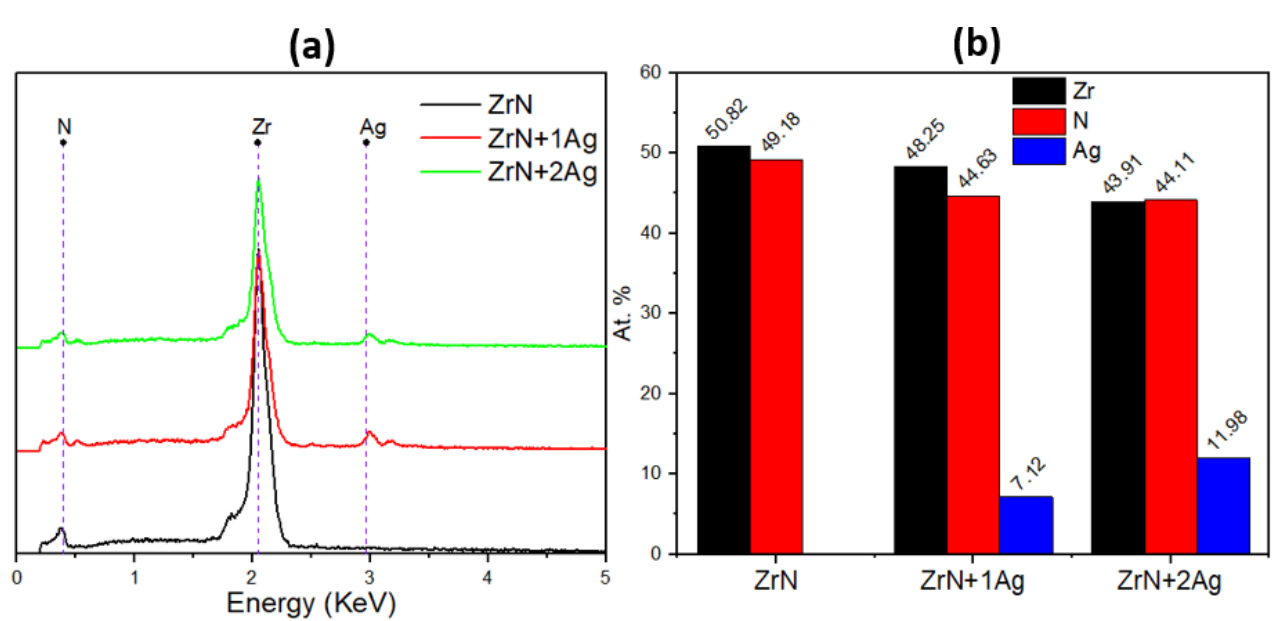
Figure 1. ( a ) EDS spectrum of the deposited coatings, and ( b ) the atomic percentage of the coatings (two measurements were done in several areas of the samples).